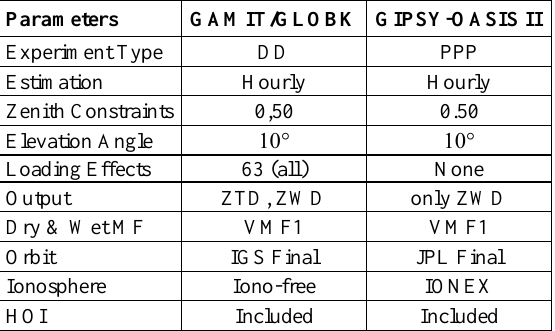
Table 1. Parameters for GNSS data processing.